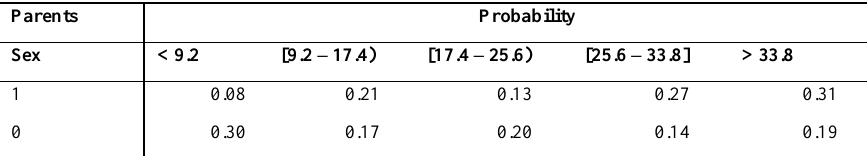
Table 4. Conditional probabilities of subject